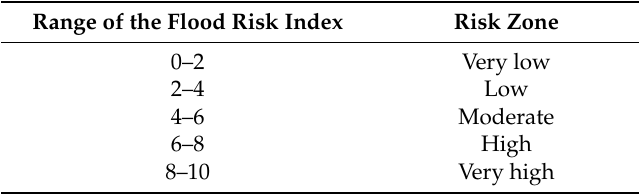
Table 8. Categorization of the flood risk index used in this